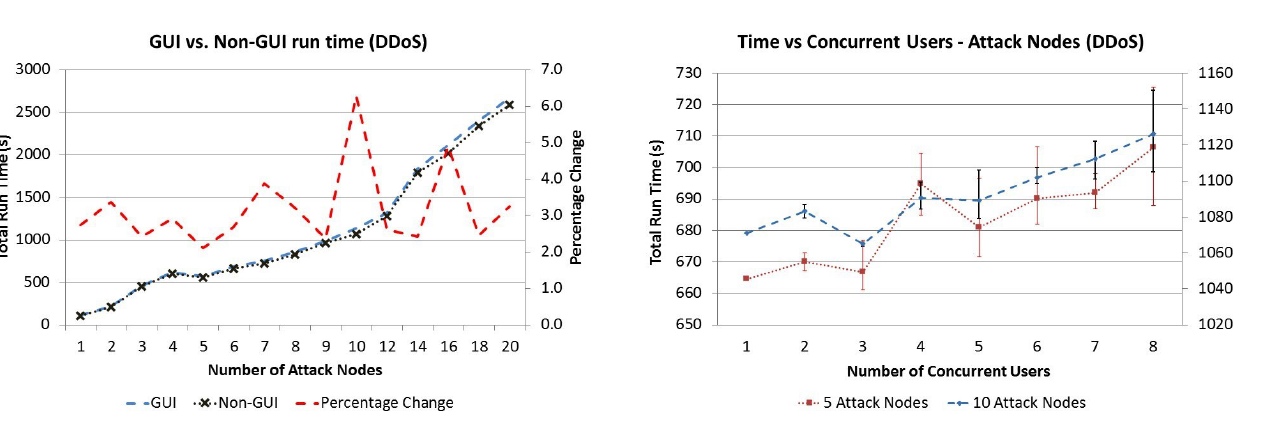
Figure 4. Run time variation with GUI and Non-GUI options, and the percentage change in two options for DDoS Attack